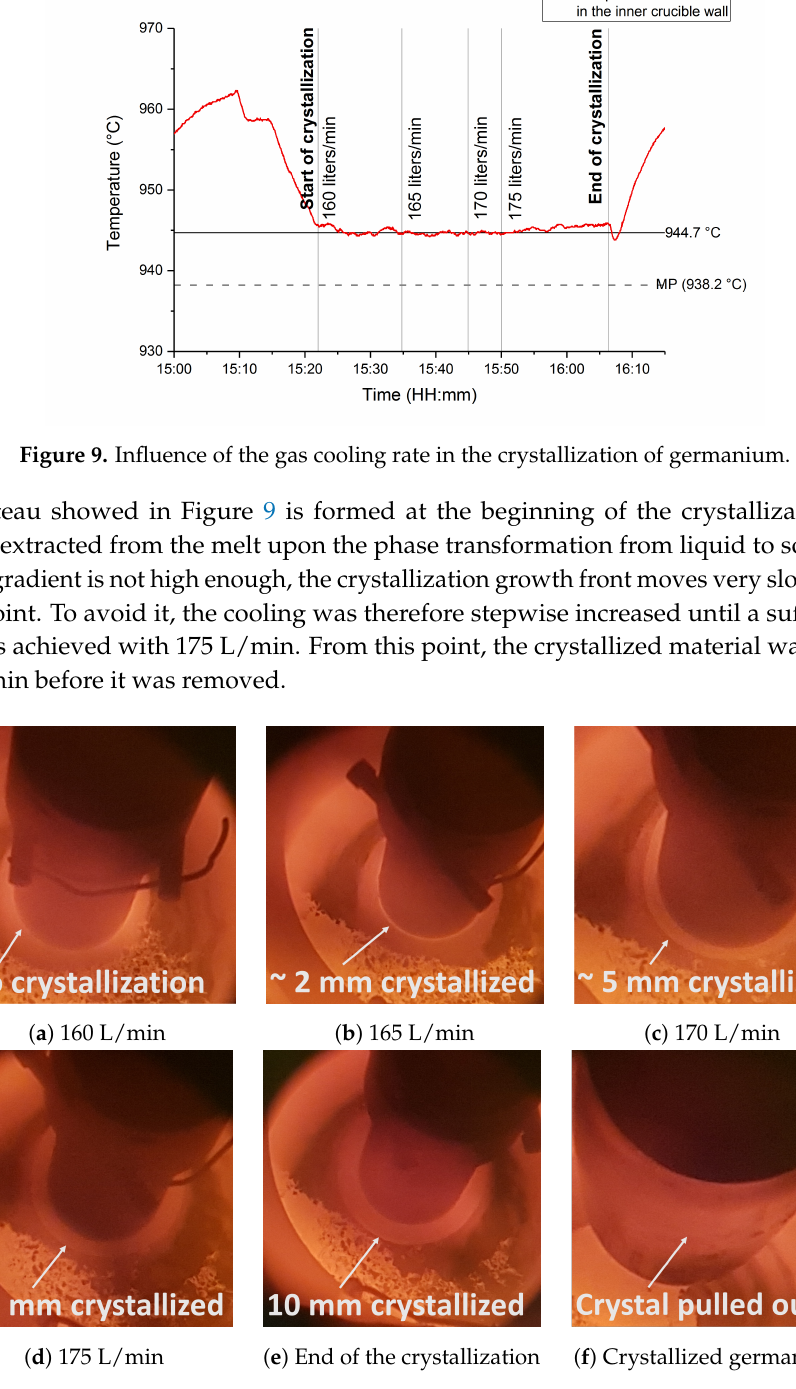
Figure 10. Influence of the gas cooling rate in the crystallization of